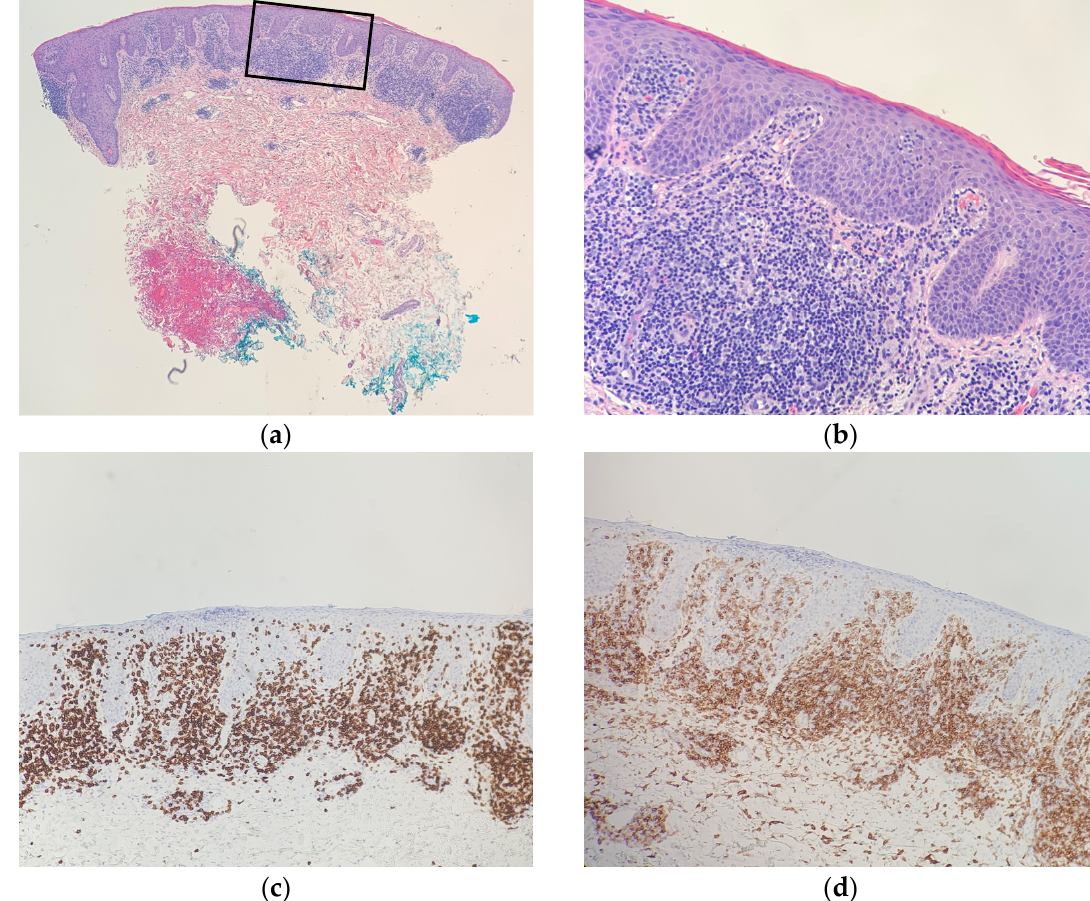
Figure 3. Right upper-arm punch-biopsy histology (hematoxylin-eosin) at magnification ( a ) ×20; ( b ) and ×40; ( c ) Immunohistochemical staining of CD8, magnification ×40; ( d ) Immunohistochemical staining of CD4, magnification ×40. Consistent with CD8+-predominant mycosis fungoides (cutaneous T-cell lymphoma).